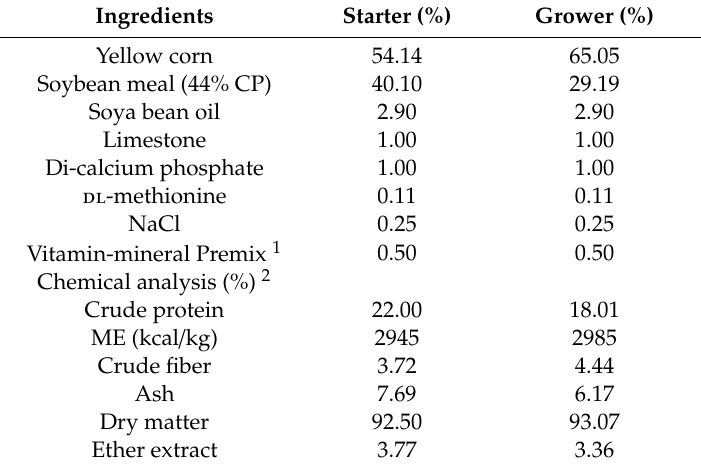
Dry matter 92.50 93.07 Ether extract 3.77